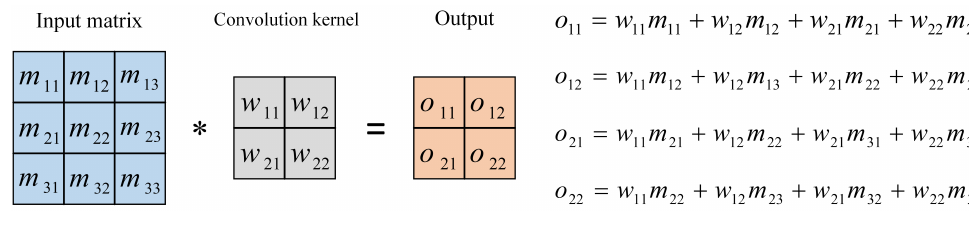
Figure 4. Convolution operation (2-D), kernel size = 2, strides = 1, padding =